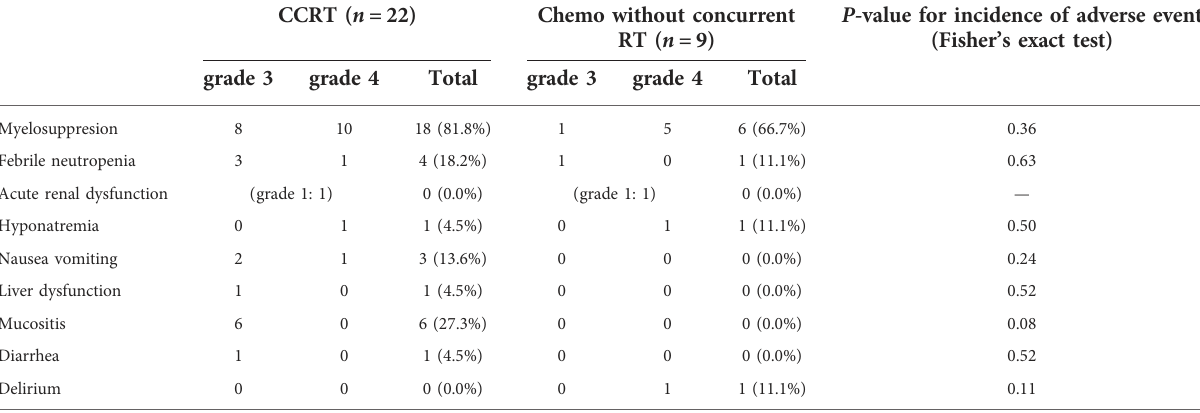
TABLE 6 Adverse events according to the CTCAE version 4.0 in the concurrent chemoradiotherapy and chemotherapy without concurrent radiotherapy groups. P -value for incidence of adverse CCRT ( n = 22) Chemo without concurrent RT ( n = 9)